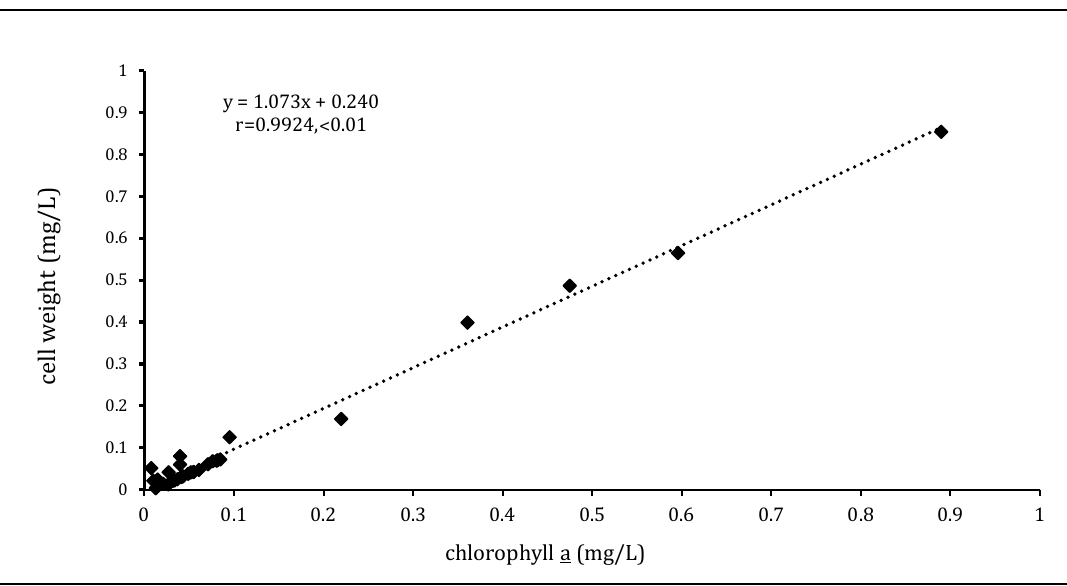
KM. supernatant of various DRMM and KM (Figure 6). Again, the total biomass of spirulina was found to be highly (P < 0.01) and directly correlated with the cell weight (r = 0.9941) of spirulina grown in the supernatant of different DRMM and KM (Figure 7).